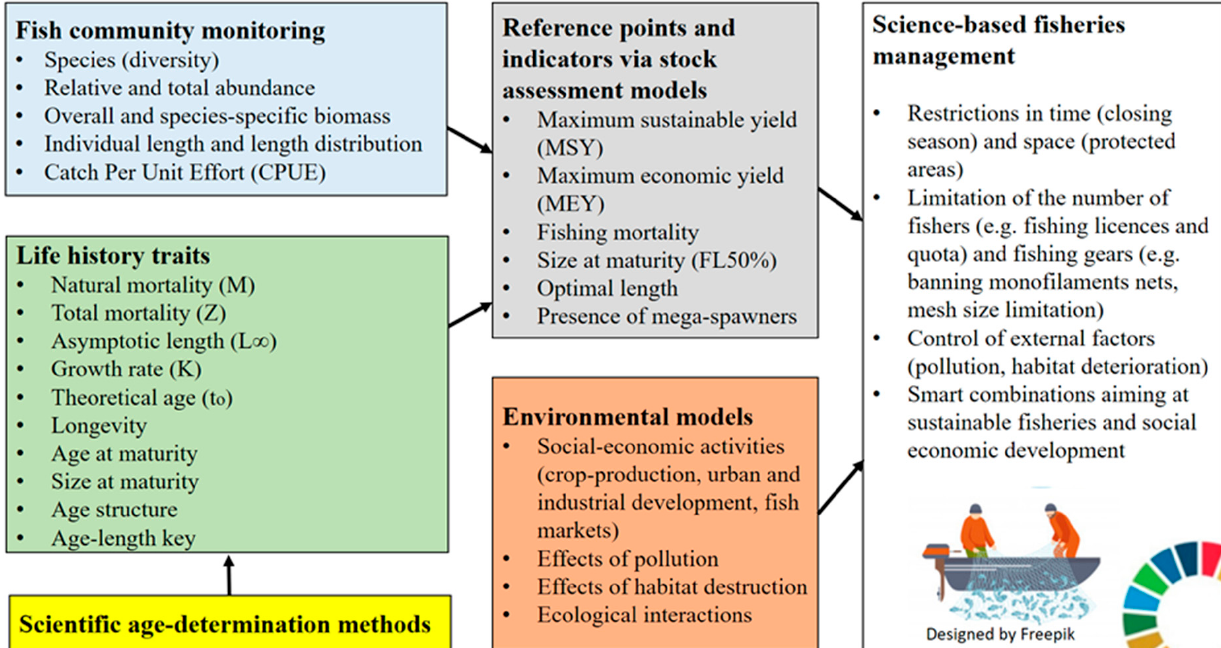
Figure 6. Schematic representation of fish community monitoring, fish stock assessment and environmental modelling to develop science-based fisheries management.